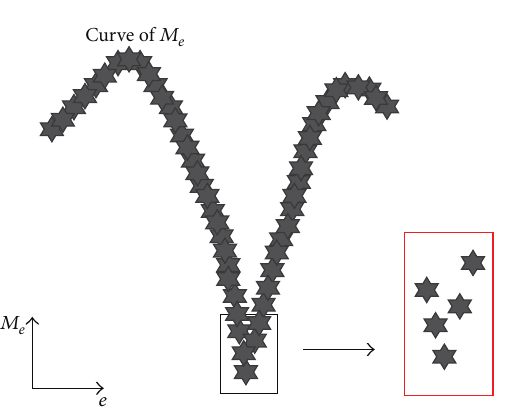
Figure 6: Curve of 𝑀 𝑒 in a common environment.